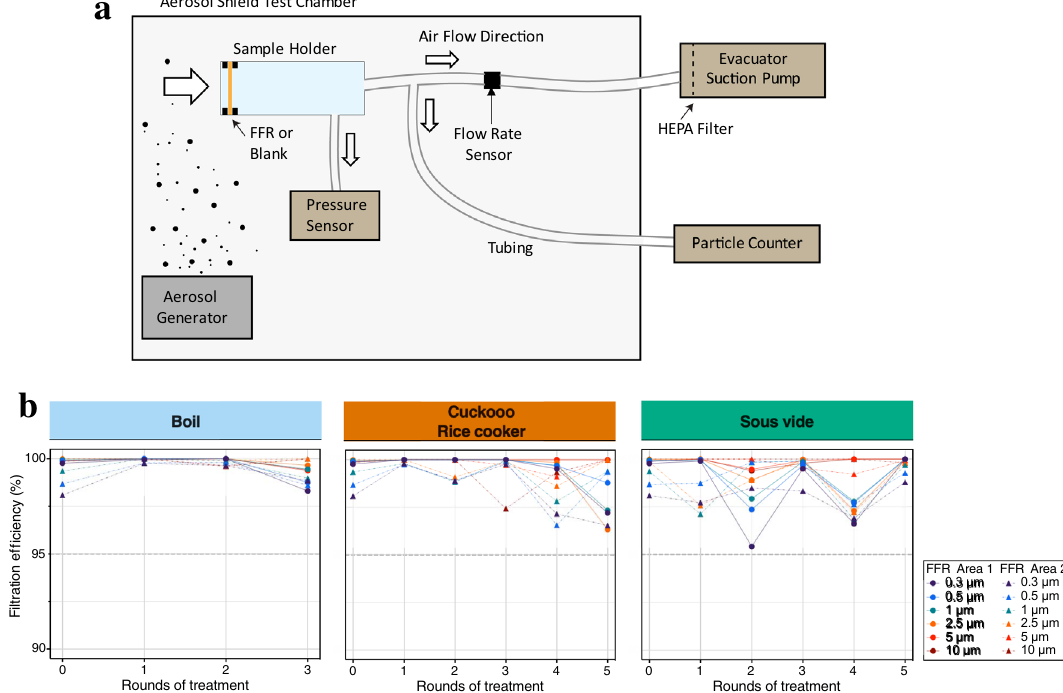
Figure 4. Filtration efficiency for control and heat-treated Halyard Fluidshield 3 FFRs. ( a ) Filtration efficiency test experimental setup. A humidifier confined by an aerosol shield test chamber was used as an aerosol generator. FFRs were attached to a sample holder and air and any suspended particles were drawn through the FFR by an evacuator suction pump and diverted to a particle counter. FFR impedance was measured through a pressure sensor attached to the sample holder. ( b ) The filtration efficiency for six different particle sizes and for two regions of heat-treated and control FFRs. None of the treatment methods reduced Halyard Fluidshield 3 FFR filtration performance below 95% for particles of any size as shown in Supplementary Table